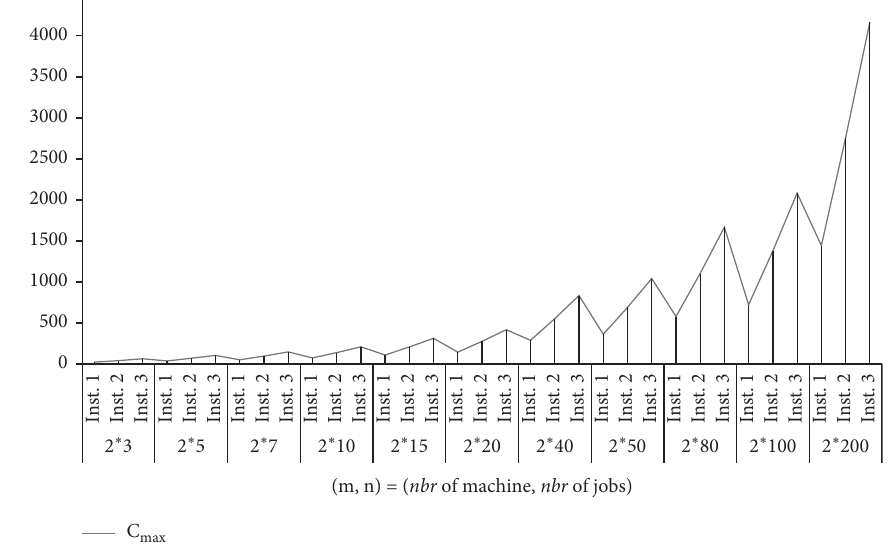
Figure 5: Evolution of the makespan, depending on the